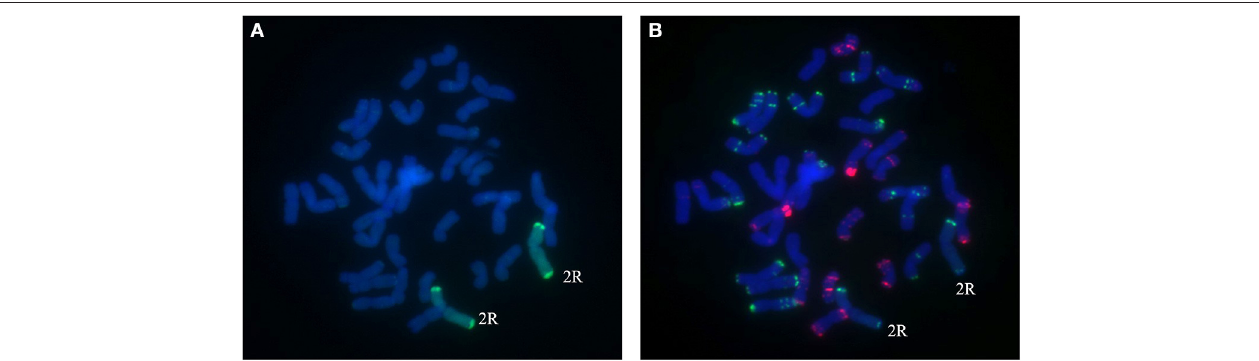
FIGURE 4 | Chromosome composition of BC 2 F 3 line 1289 by FISH (B) and GISH (A) using probe pAs1 (red) and probe pSc119.2 (green). A pair of 2R chromosomes from Sorento have been introduced into wheat.